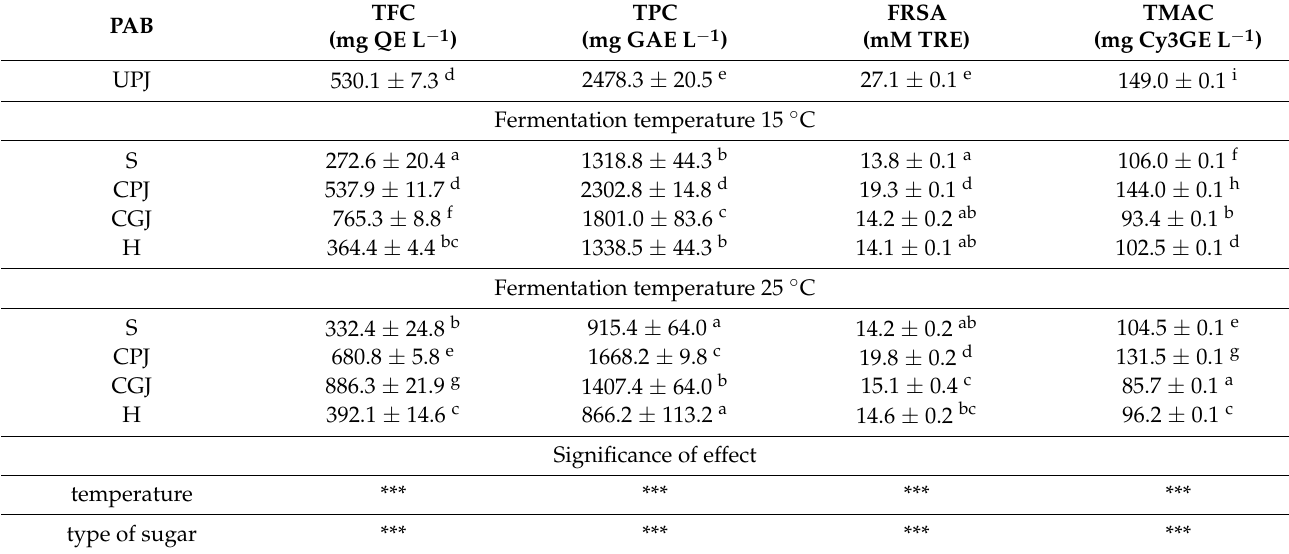
Table 2. Effect of sugar type addition and fermentation temperature on the antioxidant activity and phenolic compounds of